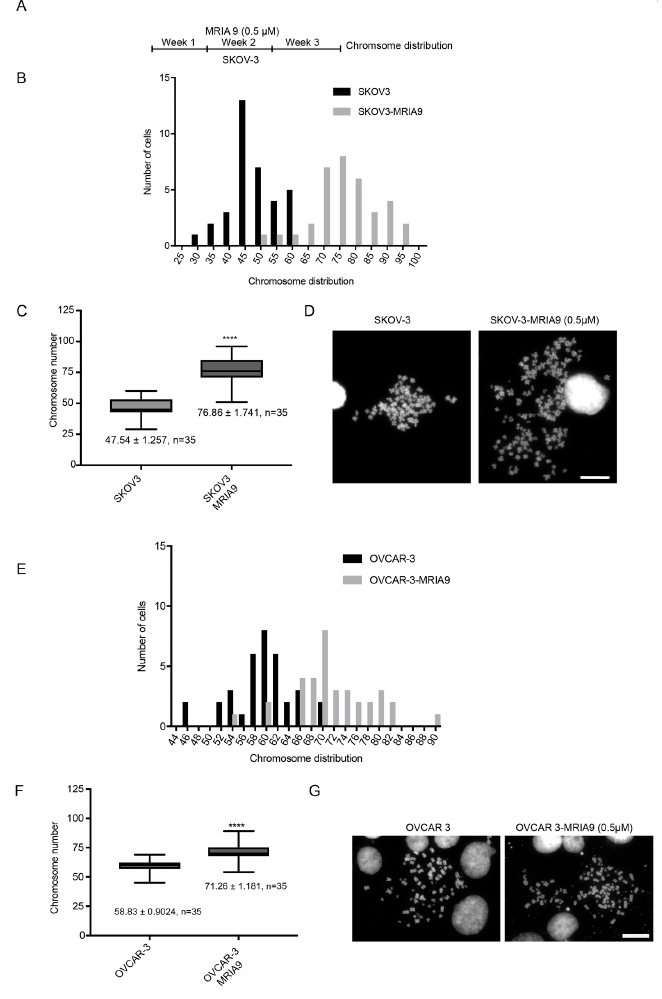
Figure 4. MRIA9-dependent inhibition of SIK2 increases chromosomal instabilities in ovarian cancer cells. ( A ) Scheme of the treatment schedule. SKOV-3 and OVCAR-3 cells were treated for three weeks with 0.5 µM MRIA9. Metaphase spreads of untreated controls and MRIA9 treated cells were prepared at the end of the incubation, and the chromosomes were stained with Hoechst. ( B ) Histogram plot of the distribution of chromosome numbers in SKOV-3 controls and SKOV-3 cells treated with MRIA9. ( C ) Quantification of the number of chromosomes in SKOV-3 controls and after incubation with 0.5 µM MRIA9 for three weeks. (mean ± SD). The results were statistically analyzed. **** p < 0.001. ( D ) Representatives of metaphase chromosome spreads. Scale bar = 20 µm. ( E ) Histogram displaying the distribution of chromosome numbers in OVCAR-3 controls and OVCAR-3 cells treated with 0.5 µM MRIA9. ( F ) Quantification of the number of chromosomes in OVCAR-3 controls and after incubation with 0.5 µM MRIA9 for three weeks. (means ± SD). The results were statistically analyzed. **** p < 0.001. ( G ) Representatives of OVCAR-3 metaphase chromosome spreads. Scale bar = 20 µm.